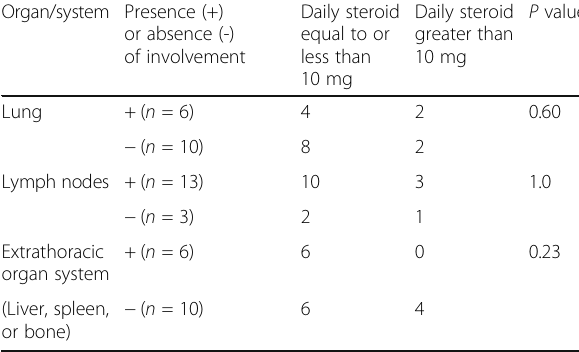
Table 3 Relationship between the presence or absence of pulmonary, lymph nodes, or extra-thoracic organ system involvement (liver, spleen, and bone) and daily oral steroid dose at 6